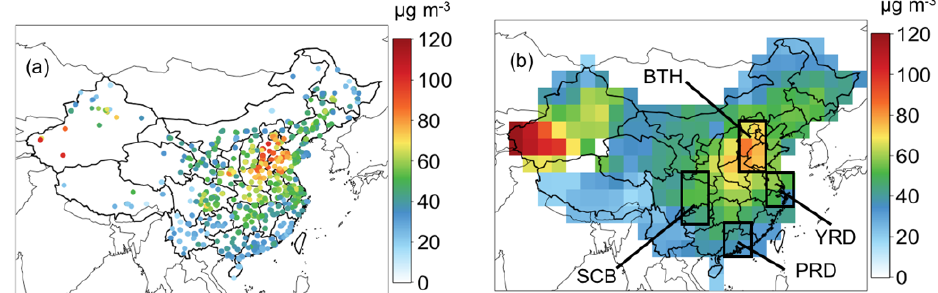
Figure 1. Average (a) site and (b) gridded 2.5 ◦ × 2.5 ◦ total PM 2 . 5 concentrations (µgm − 3 ) of China during the years 2015–2016 obtained from the Chinese Ministry of Environmental Protection (MEP, http://pm25.in; last access: 2 July 2017). Gridded data are obtained by spatially interpolating site data using an inverse weighting method as in Tai et al. (2010). The four main regions of our study are indicated in panel (b) : Beijing–Tianjin–Hebei (BTH), the Yangtze River Delta (YRD), the Pearl River Delta (PRD), and the Sichuan Basin (SCB).